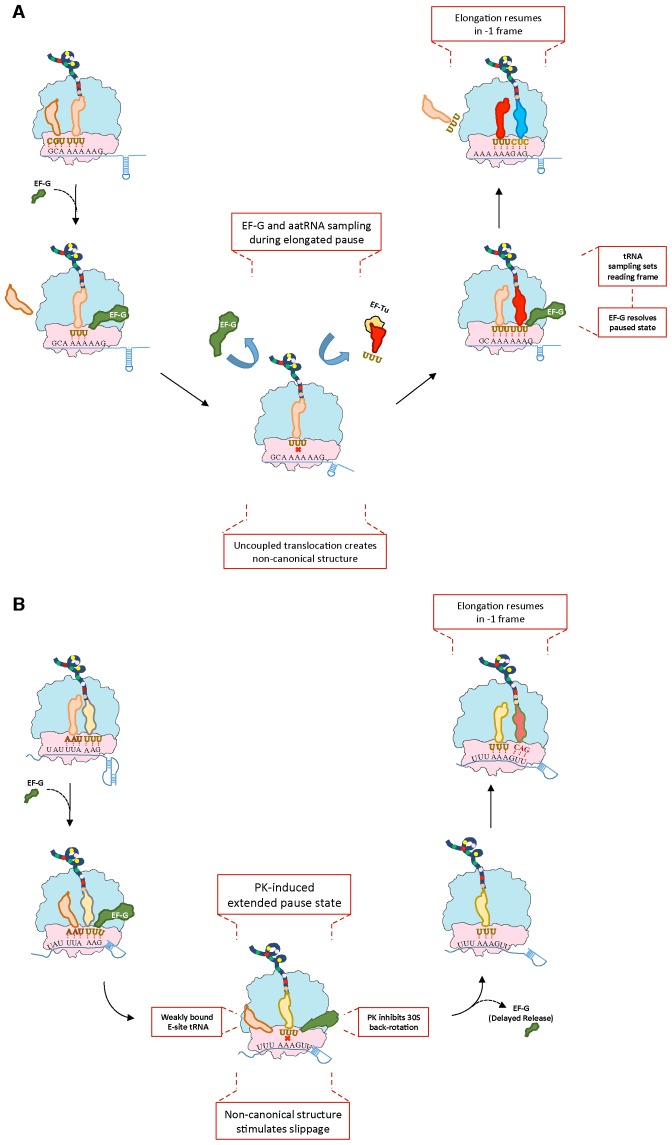
Model suggesting −1 slippage during uncoupled translocation. smFRET experiments on a dnaX-derived motif show that slippage occurs during a state of single tRNA occupancy, where the P-site tRNAAla remains after translocation is uncoupled from E-site tRNA exit in an elongated pause state. This leads to a non-canonical structure of the ribosome where EF-G samples the ribosome >5 times per codon, in parallel with A-site sampling by the incoming tRNALys. tRNALys sampling defines the reading frame, and the non-canonical state is resolved by EF-G mediated translocation, resuming elongation in the −1 frame.